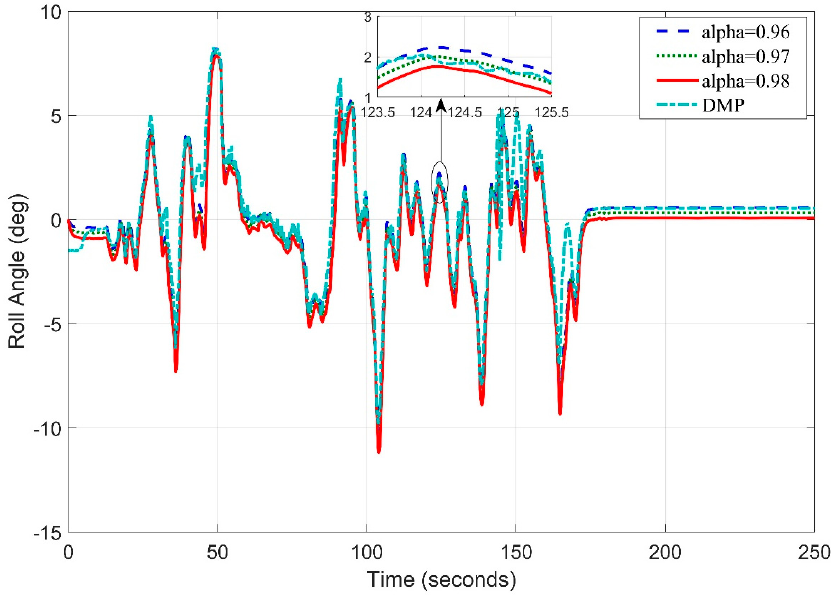
Figure 27. Real Time Roll Angle Estimate at f = 40 Hz for Complementary Filter .